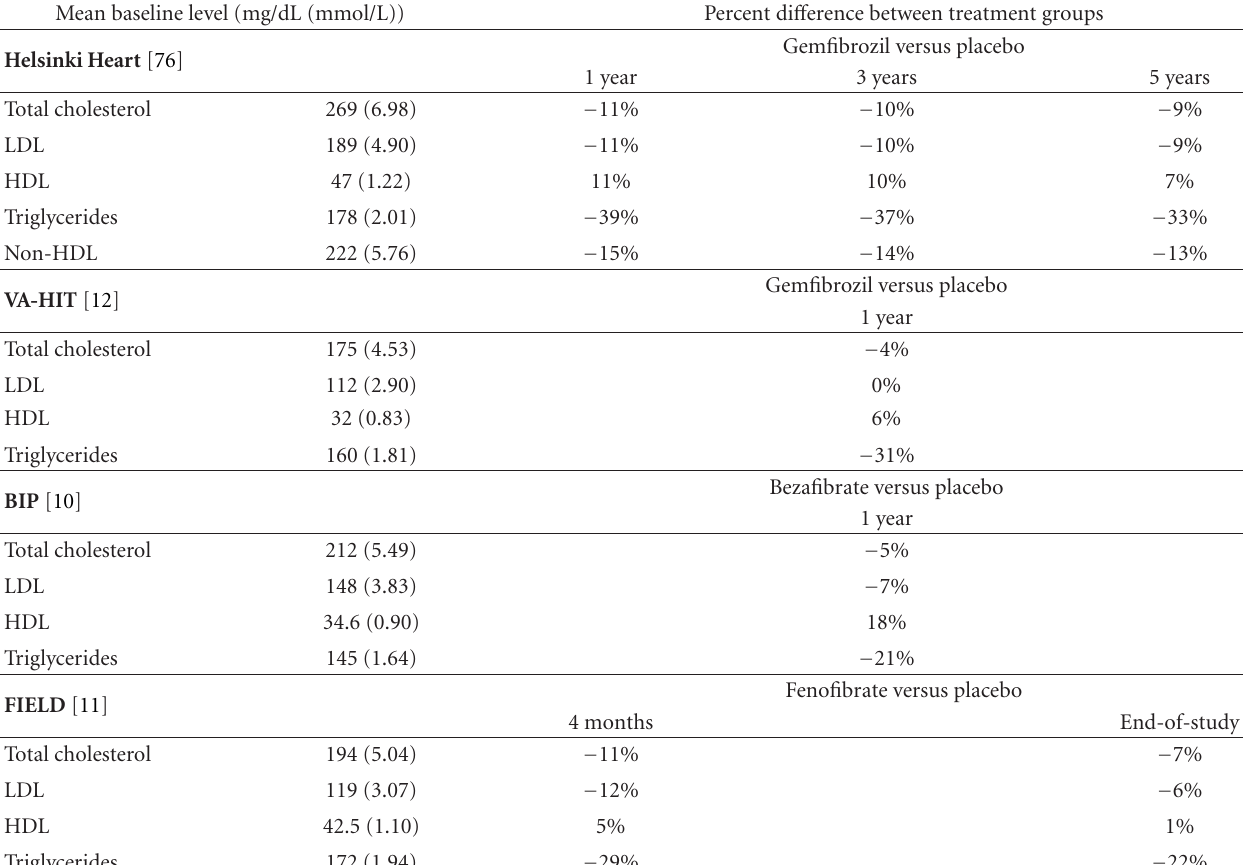
Table 2: Selected laboratory data from fibrate endpoint